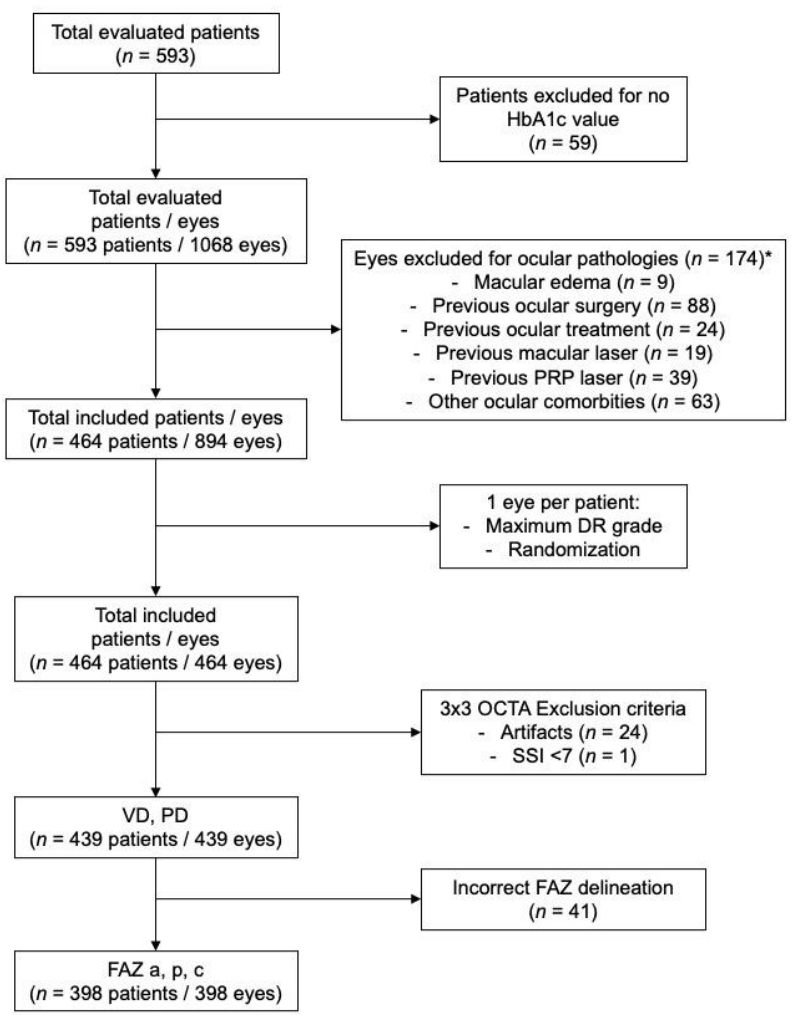
Figure 1. Consolidated standard of reporting trials (CONSORT)-style flow diagram describing included and excluded patients and eyes in each individual OCTA analysis. (* 1 eye = ≥ 1 criteria for exclusion).